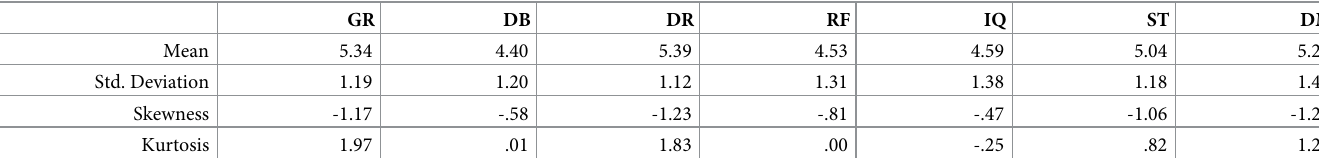
Table 2. Normal distribution test for the